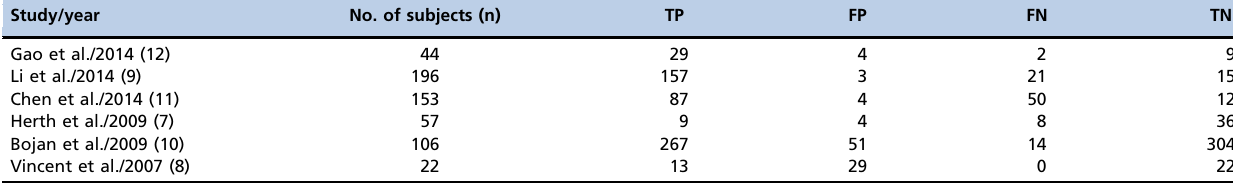
Table 1 - Characteristics of studies included in this meta-analysis